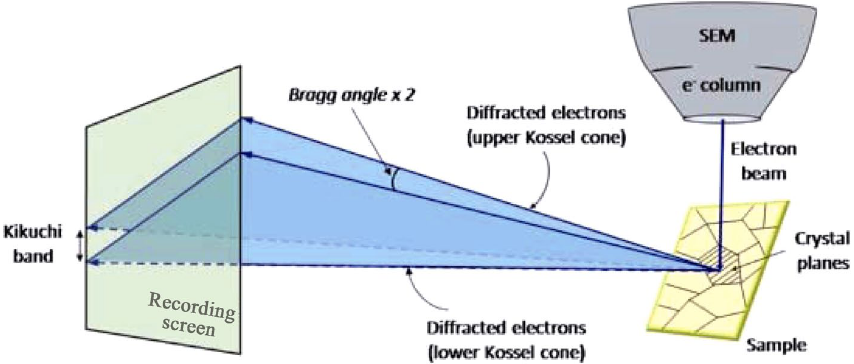
Fig. 5 Schematic of Kikuchi patterns obtained by EBSD. Reproduced with permission from Ref. [76], © Elsevier B.V. 2015.